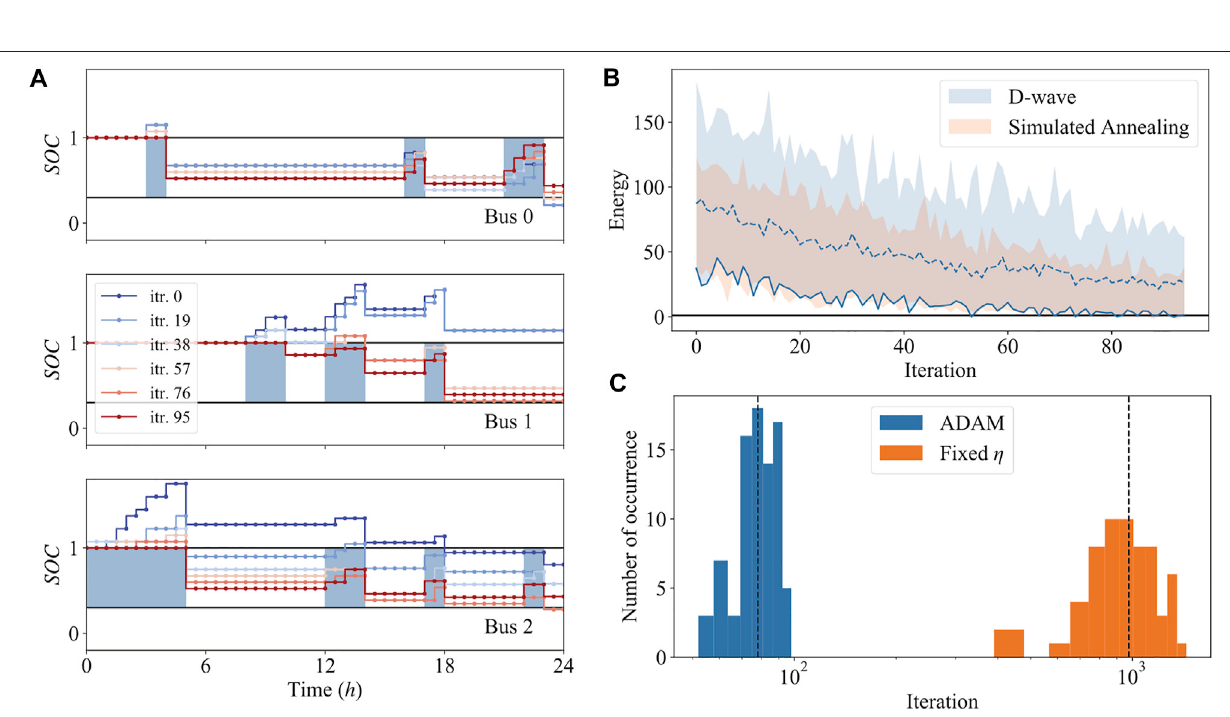
Frontiers in Physics |